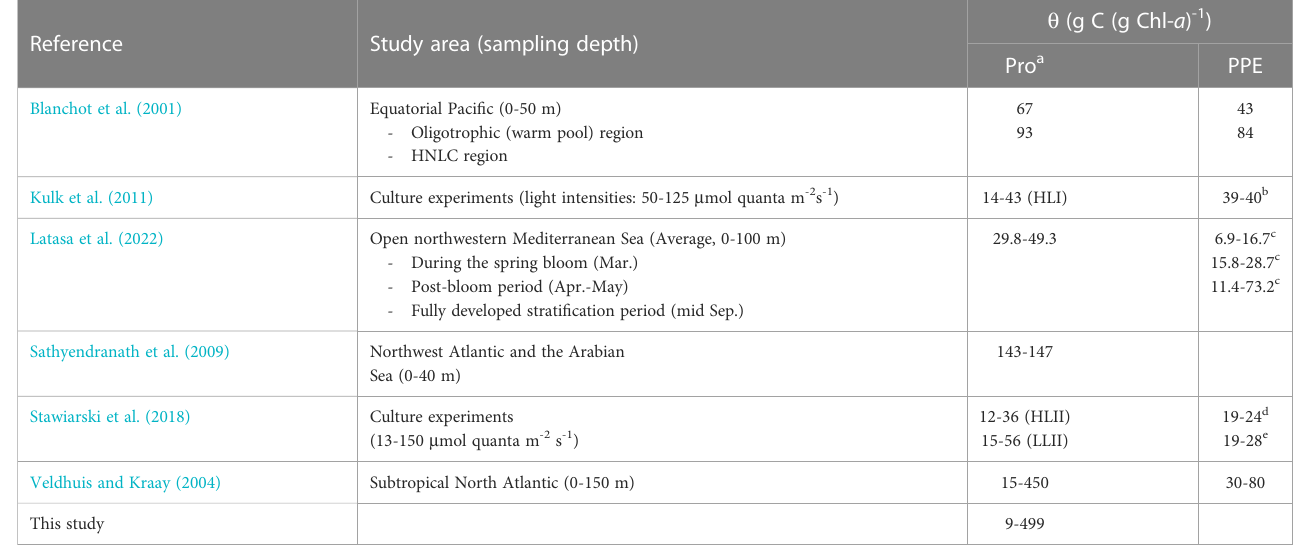
TABLE 3 Published estimates of carbon-to-(DV)Chl- a ratio ( q ) for Prochlorococcus (Pro) and photosynthetic picoeukaryotes (PPE).